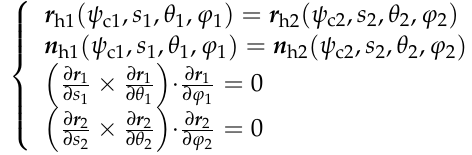
Figure 2. Example of assembly error of SBGP. In the assembly coordinate system O - x h - y h - z h , the two meshing gear teeth should have collinear normal vectors and the same coordinate values at the contact point: